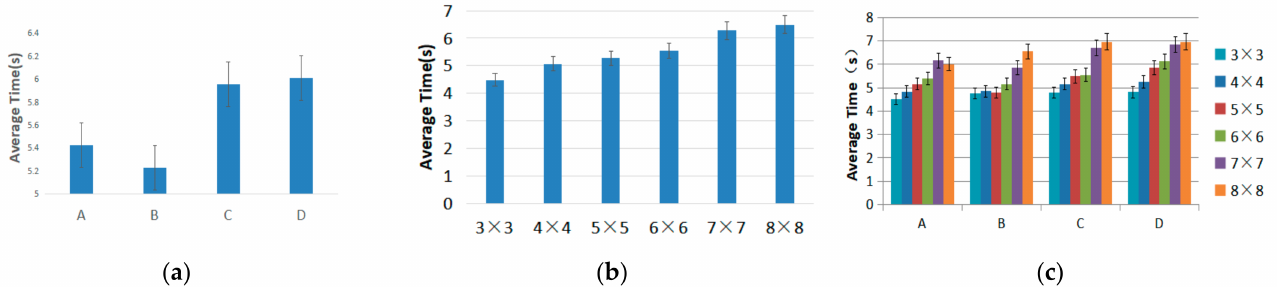
Figure 11. The average time of comparative Experiment 2. The error bars represent a 95% confidence interval: ( a ) average selection time with different regions; ( b ) average selection time with different target size levels; and ( c ) average selection time for different target size levels and different regions (A, B, C, and